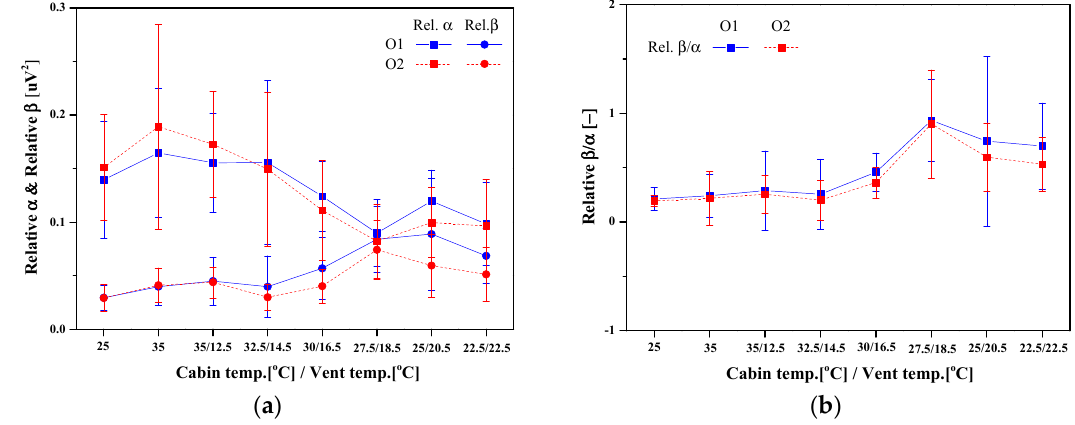
Figure 11. Variations of relative β / α -, α -, and β -waves at the occipital lobe. ( a ) Relative α and β ; ( b ) Relative β / α .